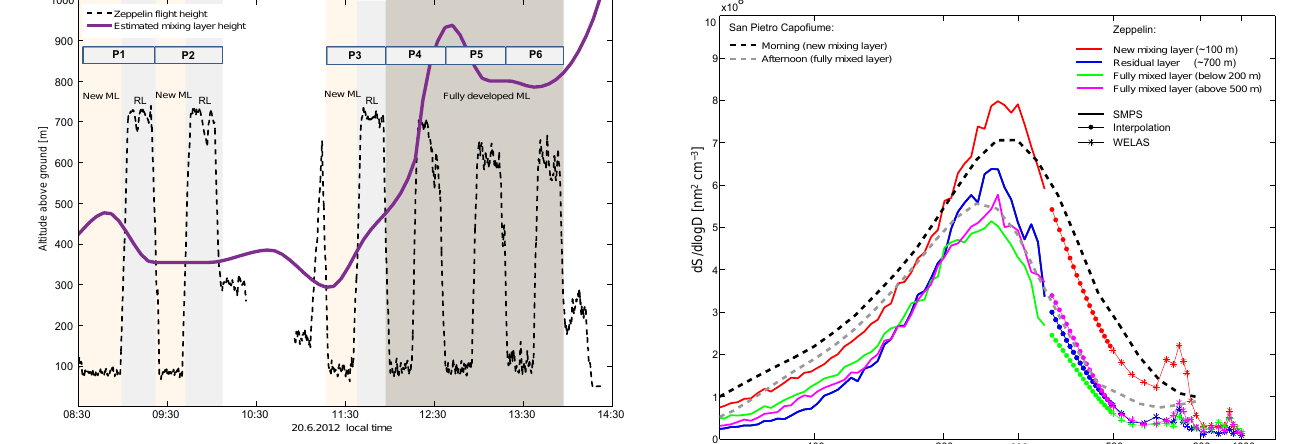
Figure 2. Overview of the flight on 20 June 2012 near San Pietro Capofiume (SPC). The black dashed line depicts the flight altitude of the Zeppelin NT airship, while the violet thick line illustrates the estimated mixing layer height. Additionally, the different lay- ers which were probed are labelled and coloured differently. Also, profiles P 1 to P 6 are marked.